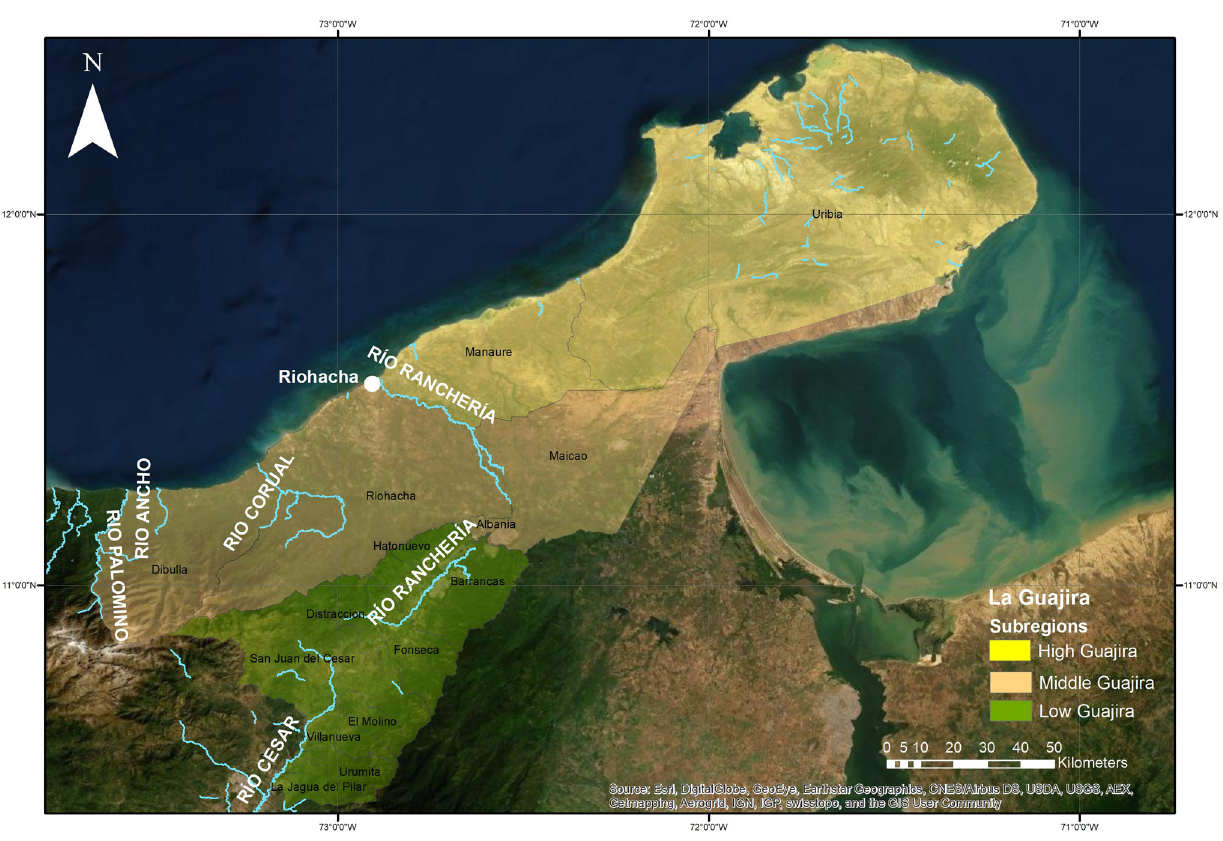
Fig. 2 Natural subregions and rivers in La Guajira Department,